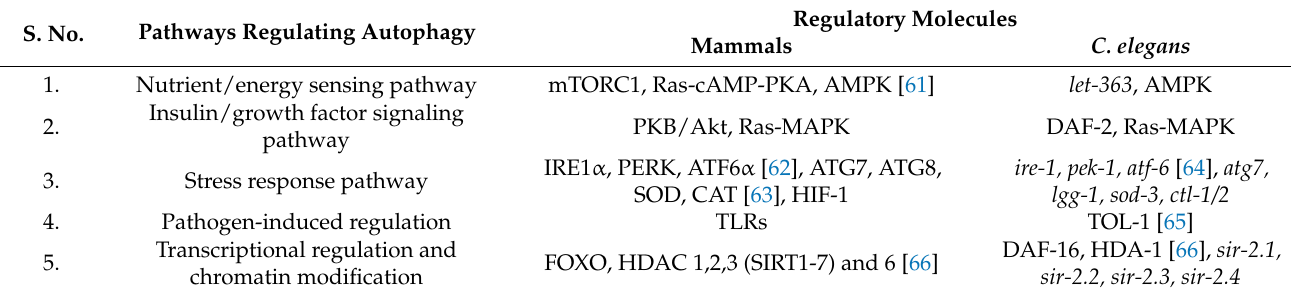
Table 1. Regulatory molecules in mammals and C. elegans, governing the process of autophagy vis-a-vis the process of neurodegeneration.